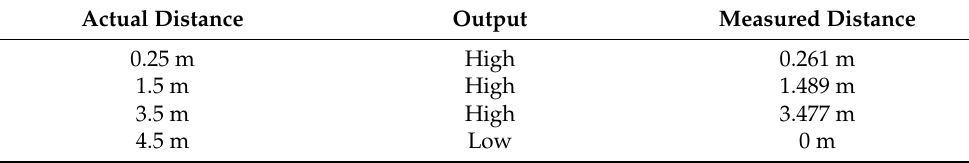
Table 3. Actual and measured